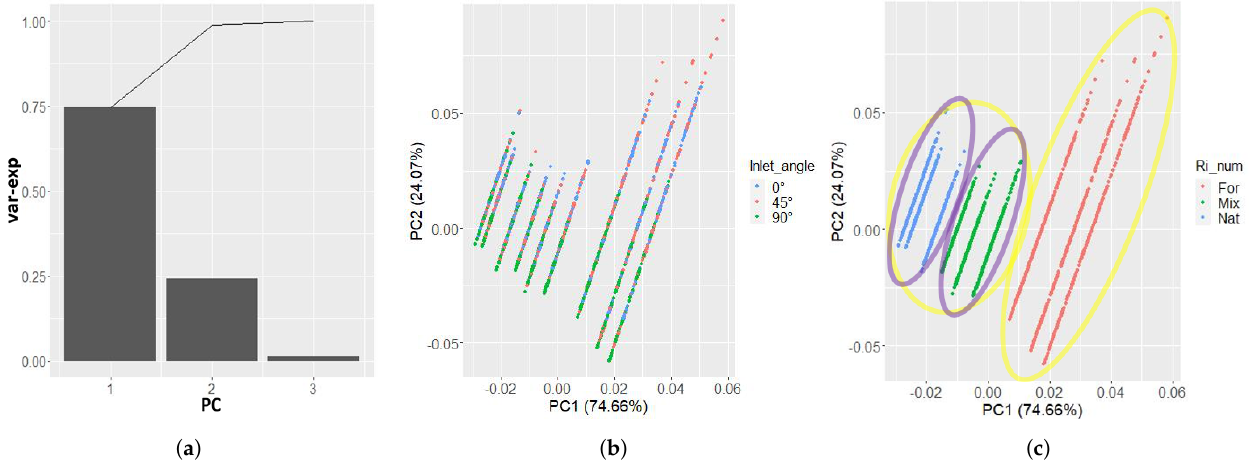
Figure 7. PC for the 10 boxes’ subdivision. ( a ) is the percentage of variance explained by the PCs, ( b ) is the datapoints displayed in the first two PCs’ orthogonal system and colored according to the three levels of the inlet angle, ( c ), similar to ( b ), but this time the datapoints are colored with respect to the three different convection types: forced (For), mixed (Mix) and natural